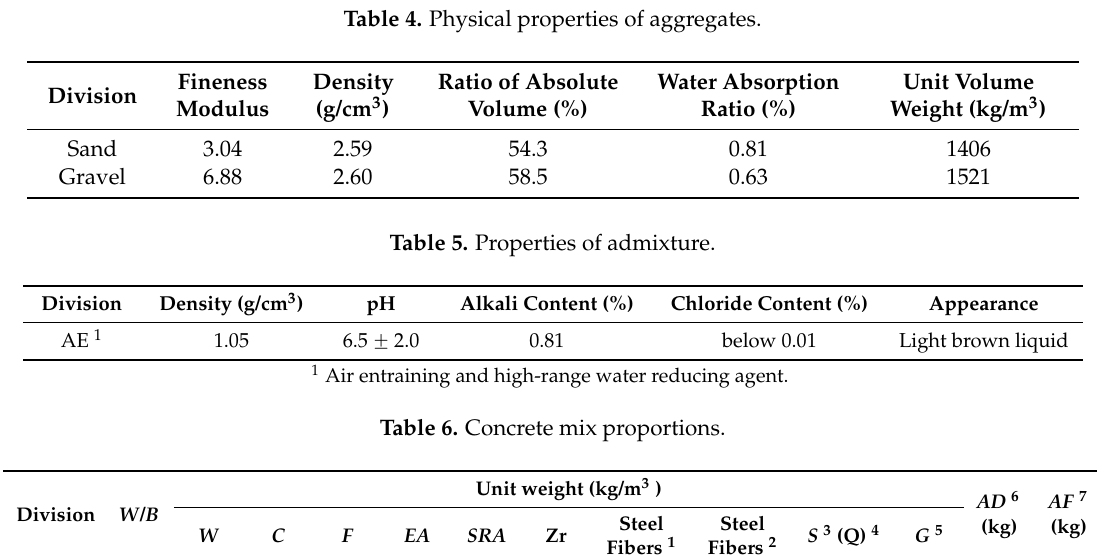
Table 4. Physical properties of aggregates.